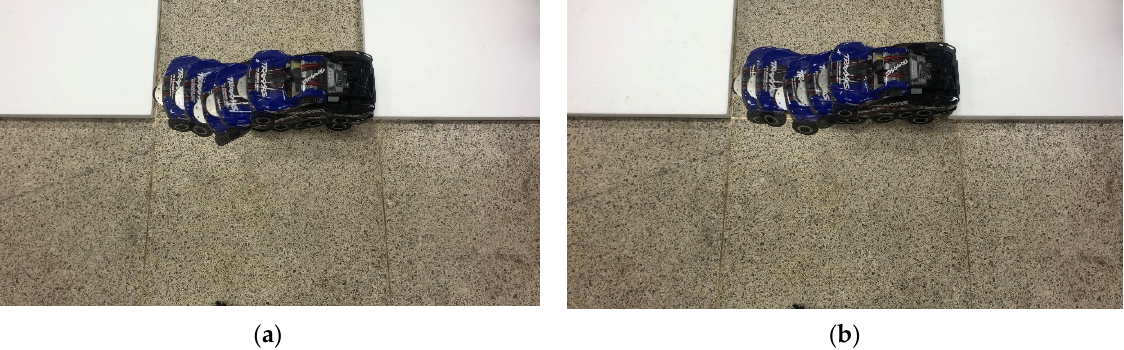
Figure 16. Repetitive three-characters ( S + R − L − ) parallel parking: ( a ) First additional action; ( b ) sec- ond additional action.